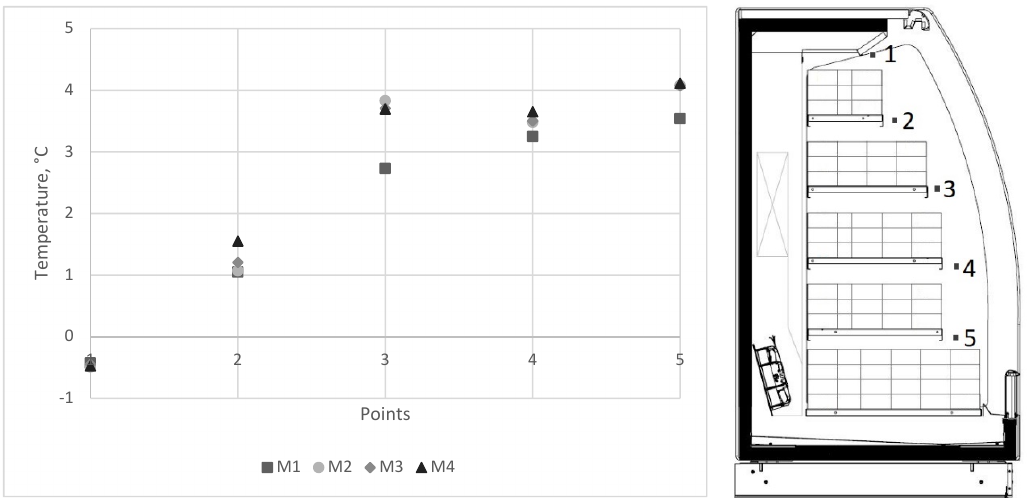
Figure 2. Temperature profile obtained for points 1–5 using meshes M1–M4.